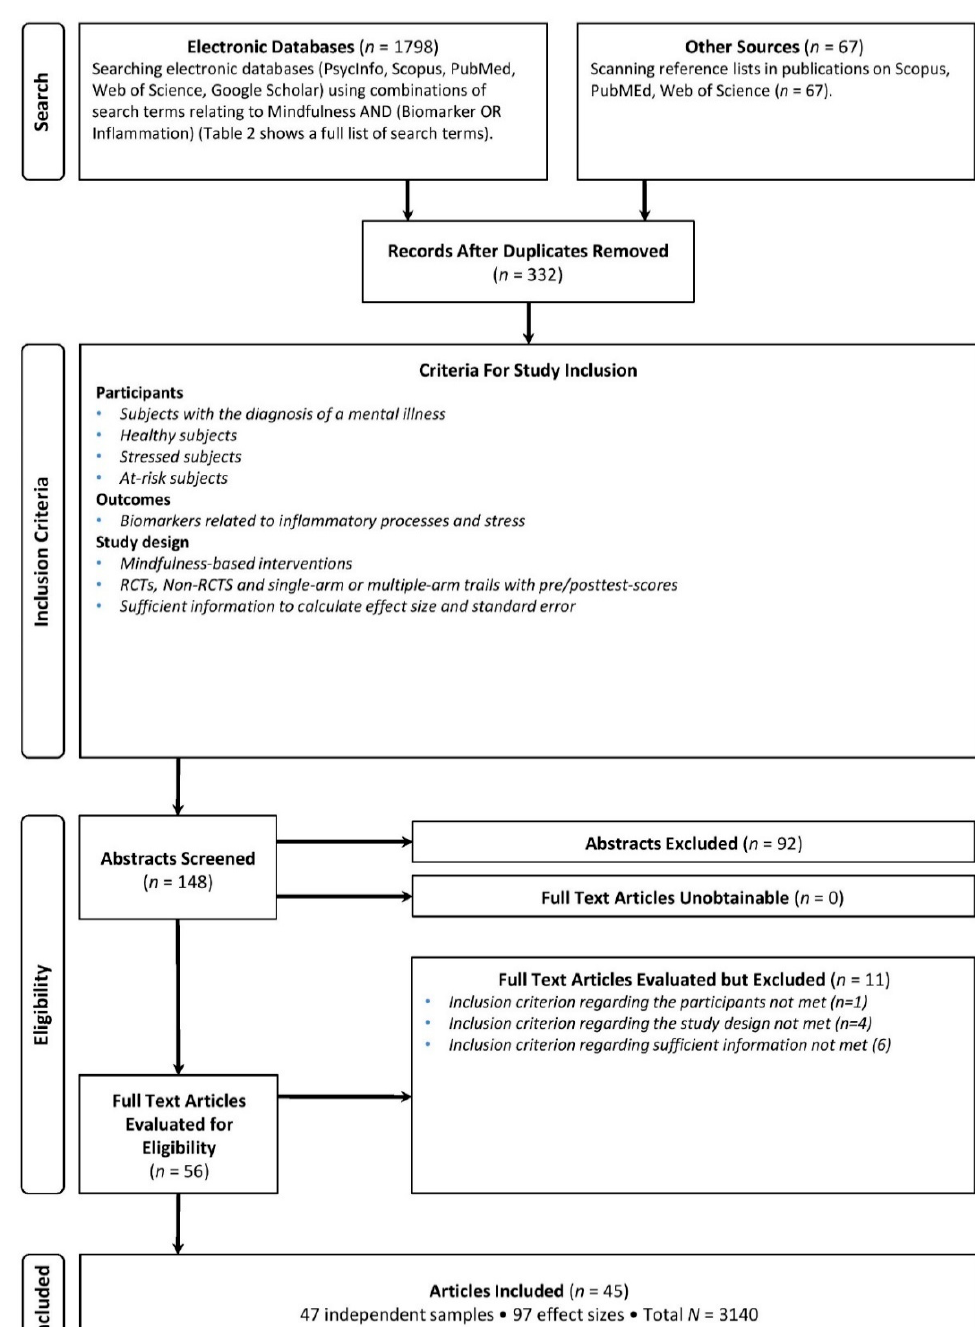
Figure 1. PRISMA Flow Diagram.